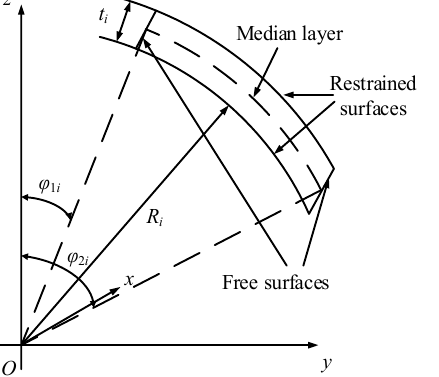
Figure 4. The boundary conditions and loading of rotational rubber